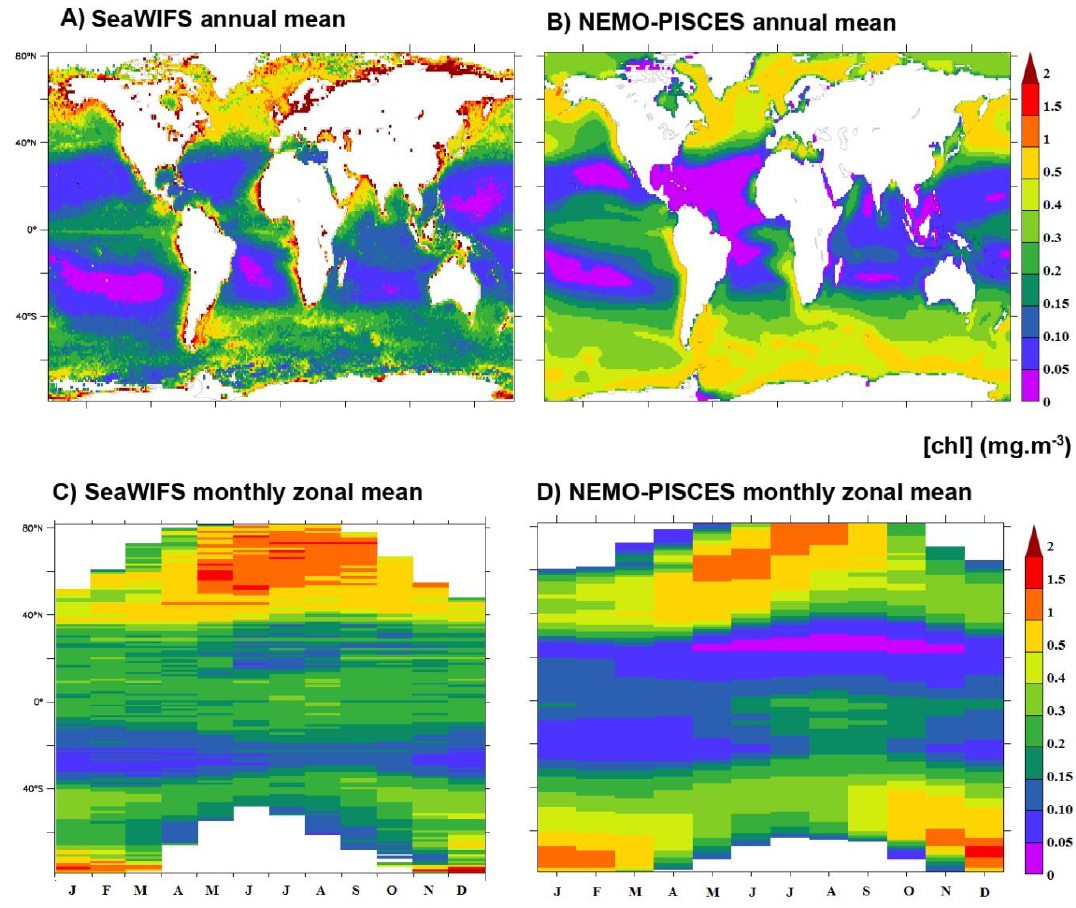
Figure 4. Comparison of remotely sensed observations of chlorophyll (left panels) with simulations performed using the NEMO-PISCES model (right panels). Top panels (a, b) represent maps of annual mean chlorophyll concentration (mgm − 3 ). Bottom panels (c, d) represent latitude–time maps of